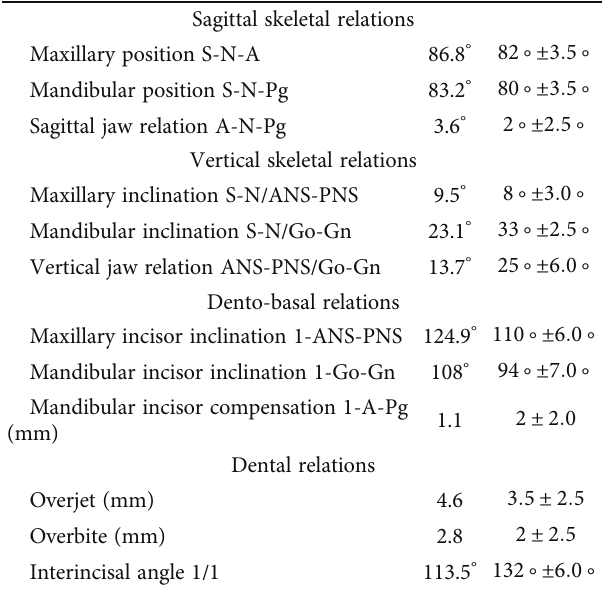
Table 5: Post-treatment Ebo cephalometric values.